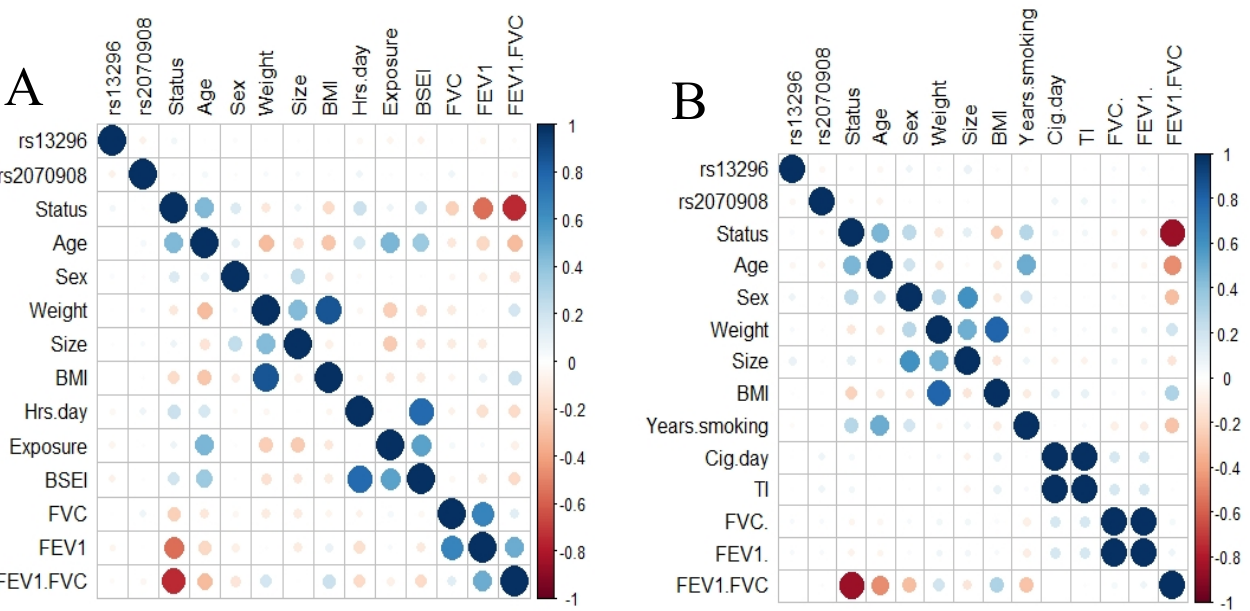
Figure 1. Correlation analysis. Correlation plot for smokers’ group ( A ) and exposed to biomass smoke ( B ). No correlation was found between the SNPs studied and any clinical variable.